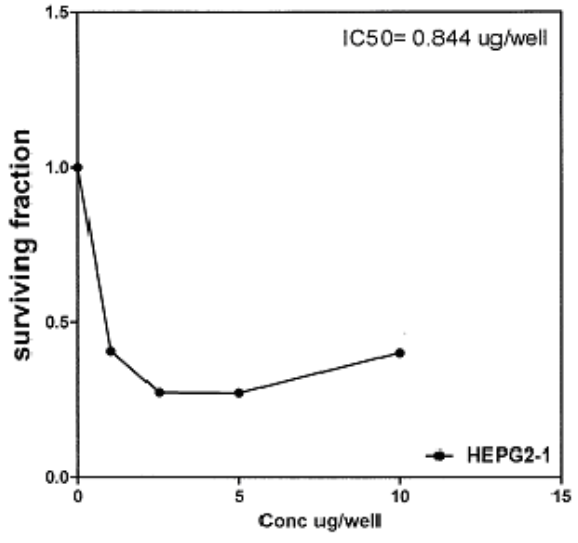
Figure 7. Effect of conc. of 2b on HEPG2 line.